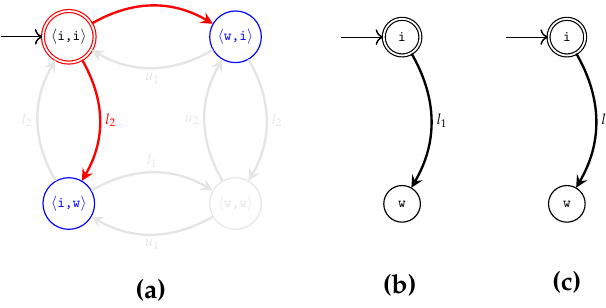
Figure 8. MPL—First Iteration. ( a ) Explorer; ( b ) R1; ( c )